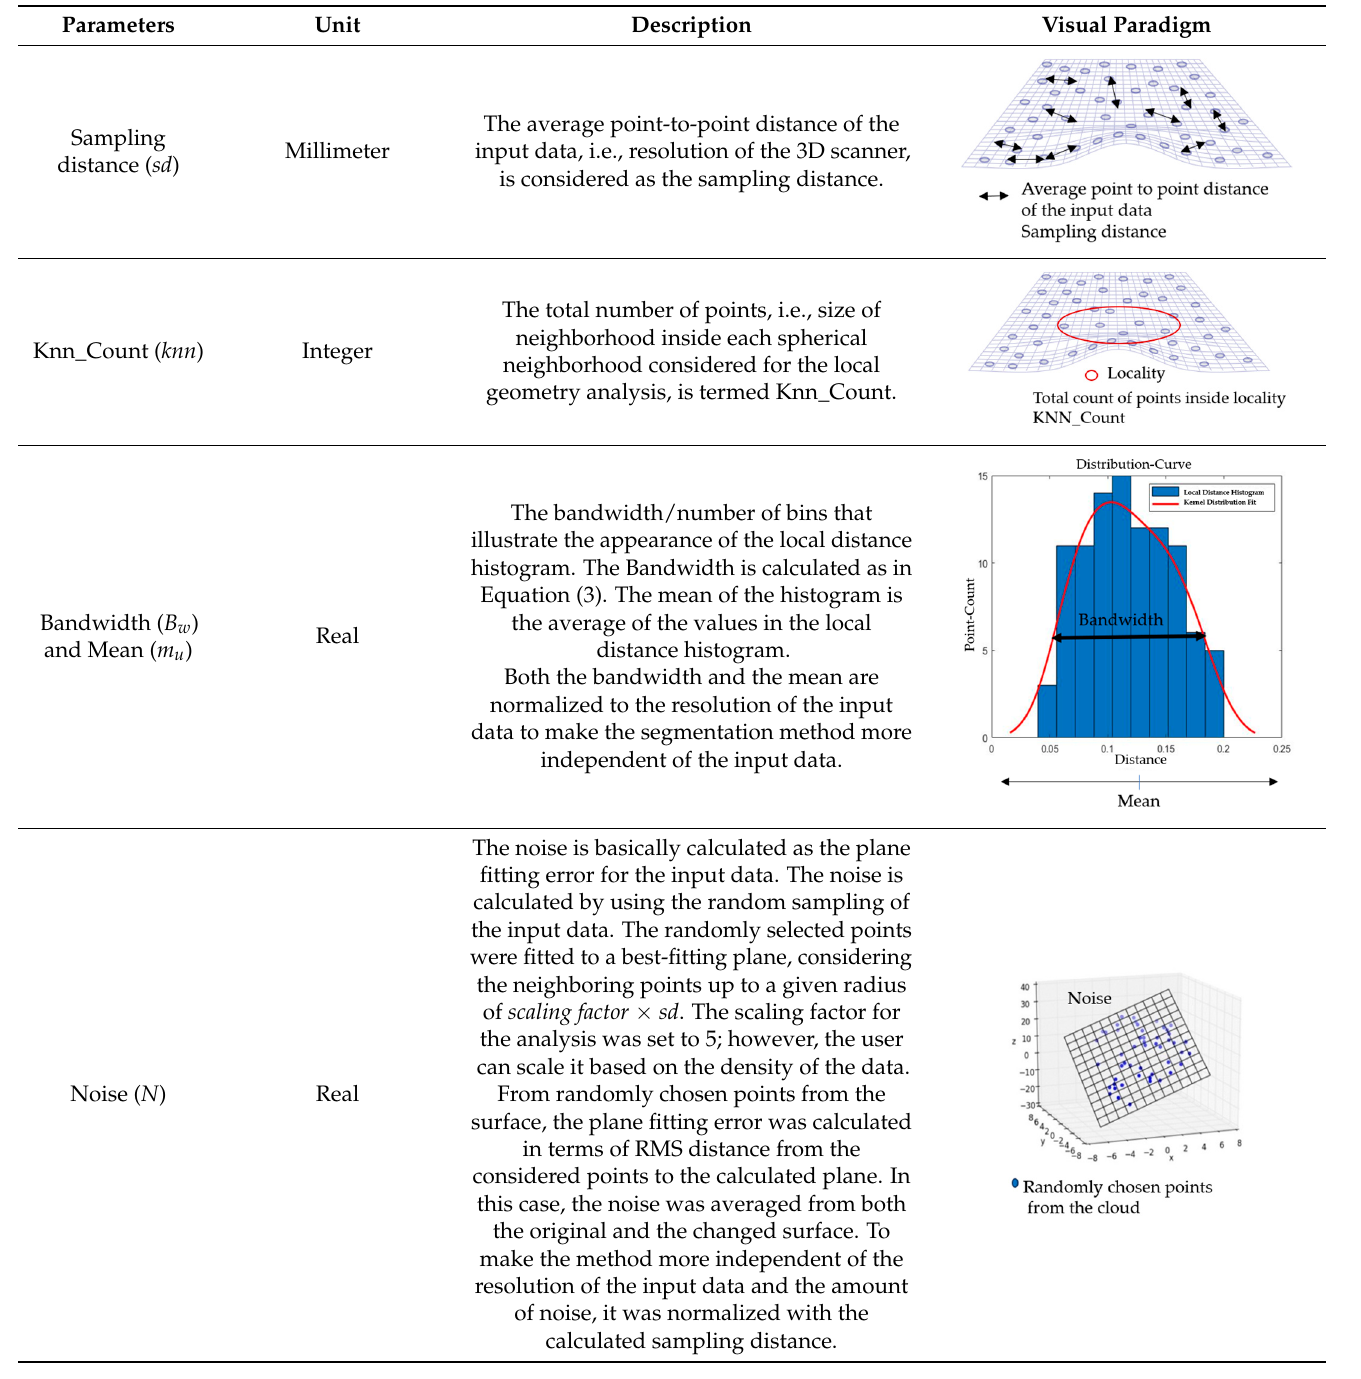
Table 2. User input thresholds to the segmentation method.